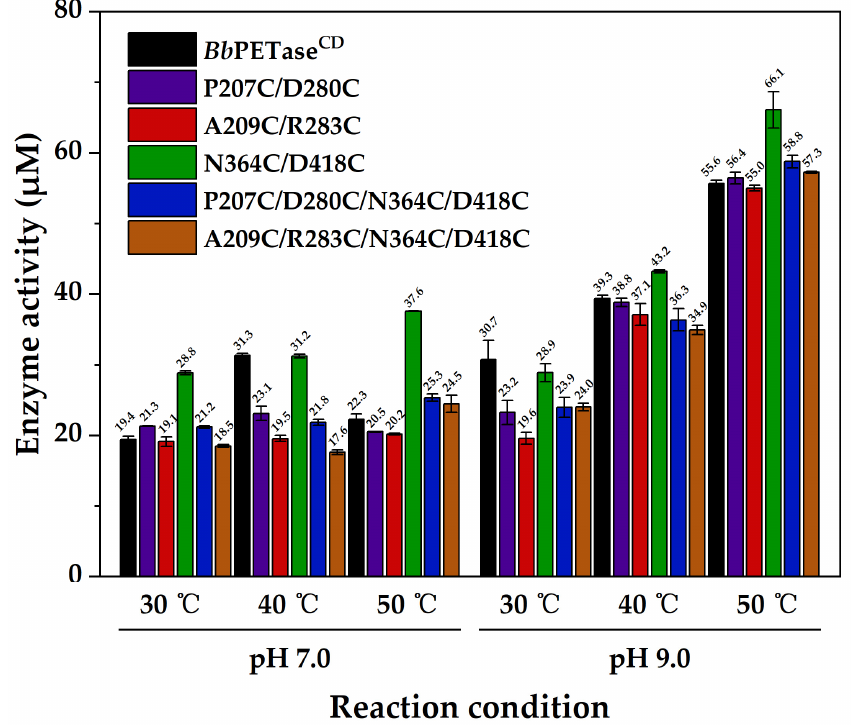
Figure 1. Activity of Bb PETase CD and its variants using BHET as substrate. The final concentration of enzyme was 50 nM. The fi nal concentration of BHET was 200 mg/L.